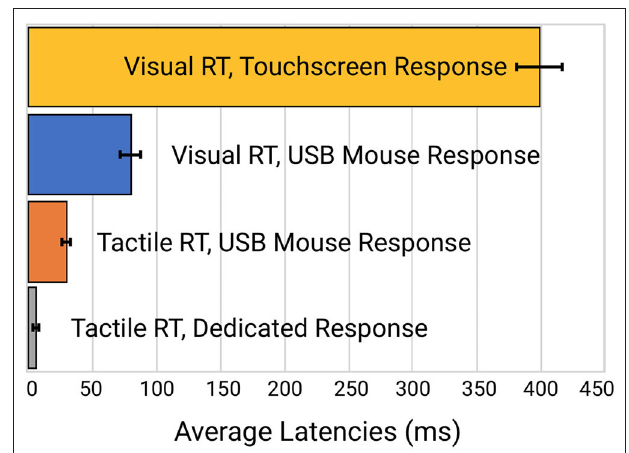
FIGURE 4 | Comparison of the latency errors of four different methods of reaction time